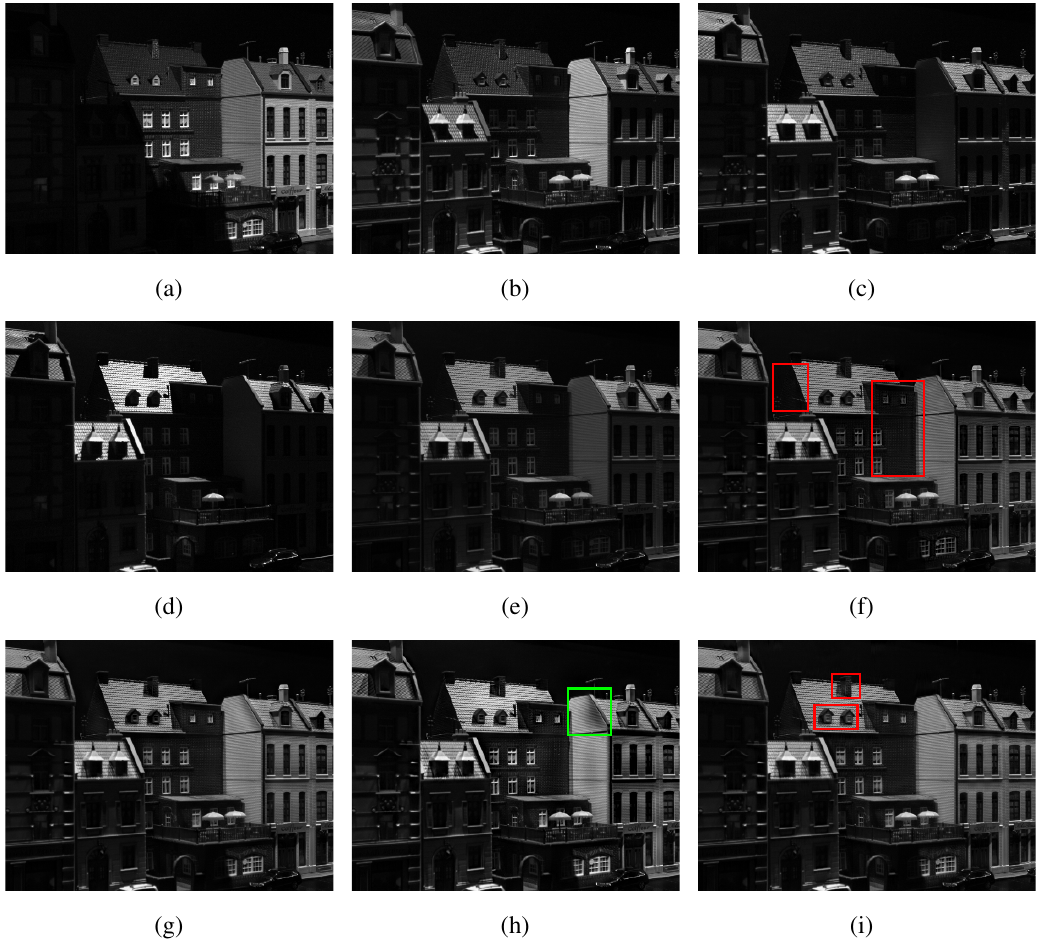
Figure 7. Multi-exposure image fusion results for Dataset 1. ( a ) Image 1; ( b ) Image 2; ( c ) Image 3; ( d ) Image 4; ( e ) PCA; ( f ) DWT; ( g ) non-subsampled contourlet transform using